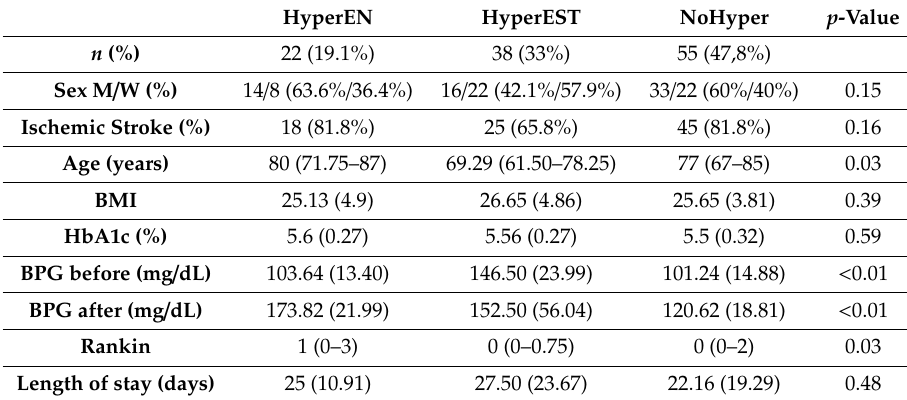
Table 1. Di ff erences in variables between study groups.